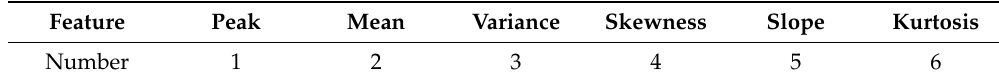
Table 4. Feature number.